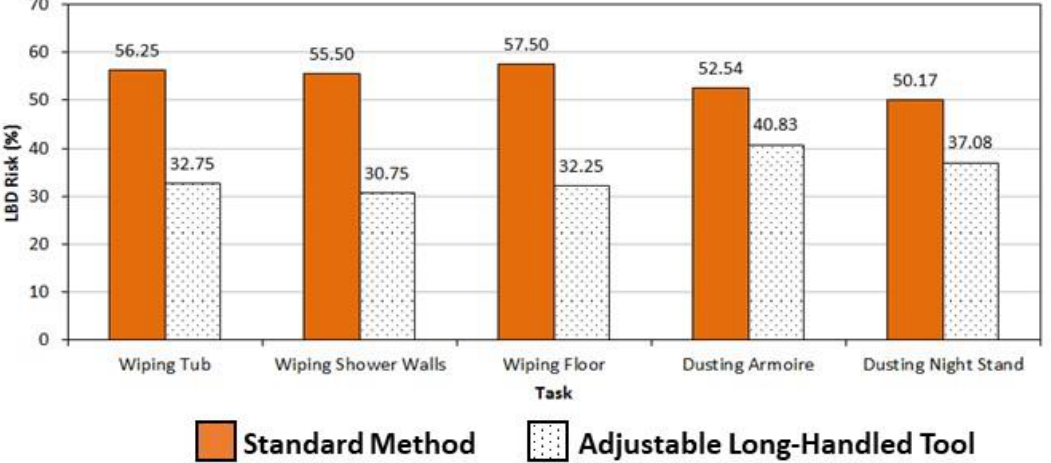
Figure 7. Differences in average LBD risk between cleaning methods of five bathroom and furniture cleaning methods. All were significantly different ( p < 0.05). cleaning methods. All were significantly different ( p <